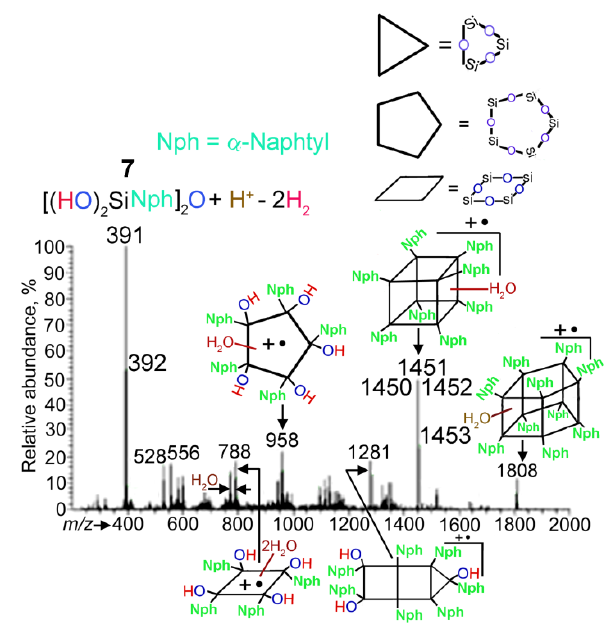
Figure 11. PI APCI mass spectrum of α -naphtylsiloxane compounds from the hydrolysis-condensation reaction of 3 carried out at C HCl = 0.037 mol L −1 for 24 h.